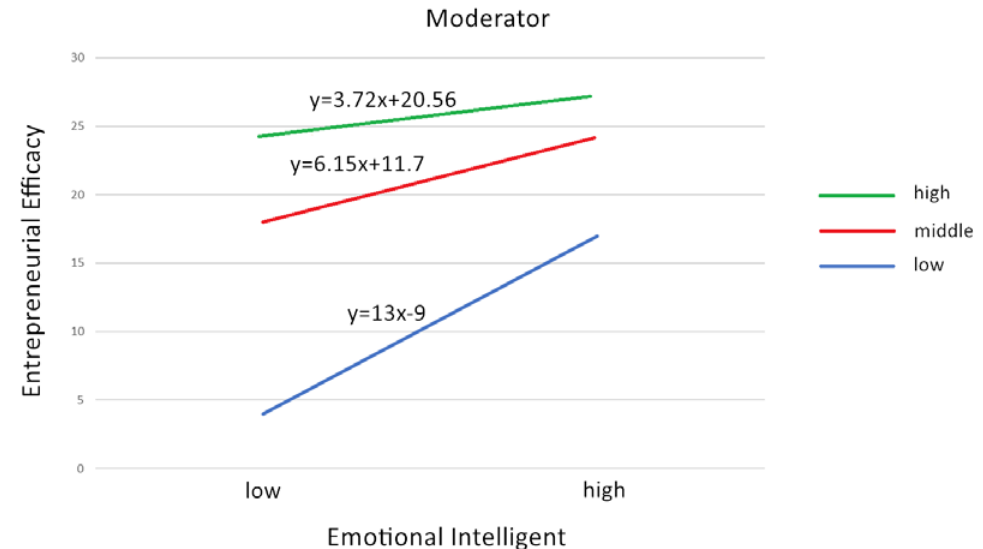
Figure 1. Relationship between different levels of emotional intelligence and entrepreneurial self- efficacy.